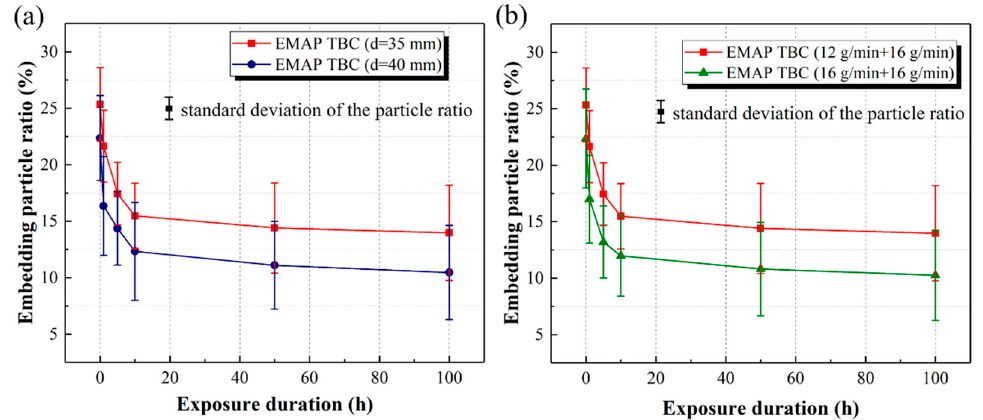
Figure 9. Evolution of the embedded particle structure of the coatings prepared in two different systems during a thermal exposure test: ( a ) EMAP TBC prepared with different distances between powder feeder 1 and powder feeder 2, and ( b ) EMAP TBC prepared with different feeding rates for powder feeder 1 and powder feeder 2.